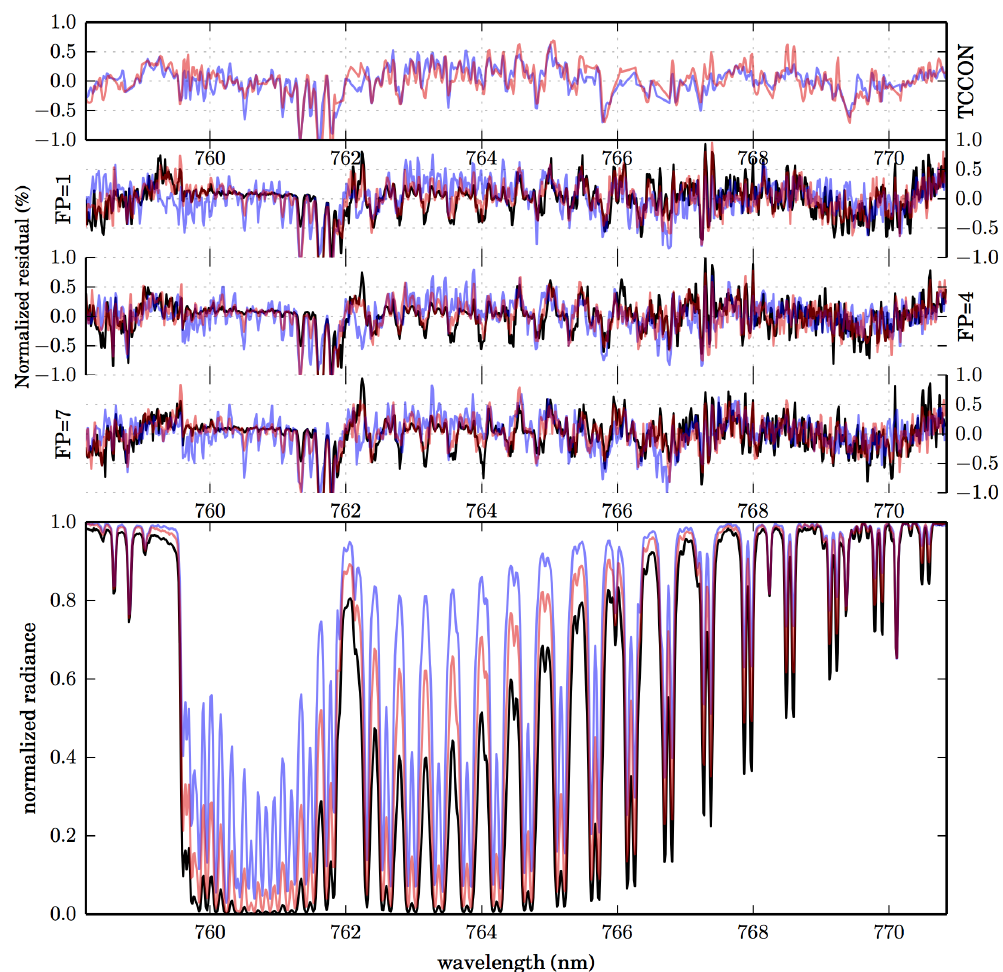
Figure 3. Spectral fits to direct-sun measurements in the O2A band of OCO-2 and TCCON. Normalized radiances from OCO-2 are shown in the bottom panel for three different air masses (low (1.1), typical (2.5) and high (5.1) in blue, red and black, respectively). The middle panels show residuals of fits to normalized spectra, for three OCO-2 footprints, and the top panel shows fit residuals to a high-resolution FTS spectrum of identical air mass, which was convolved and resampled to OCO-2 spectral resolution prior to